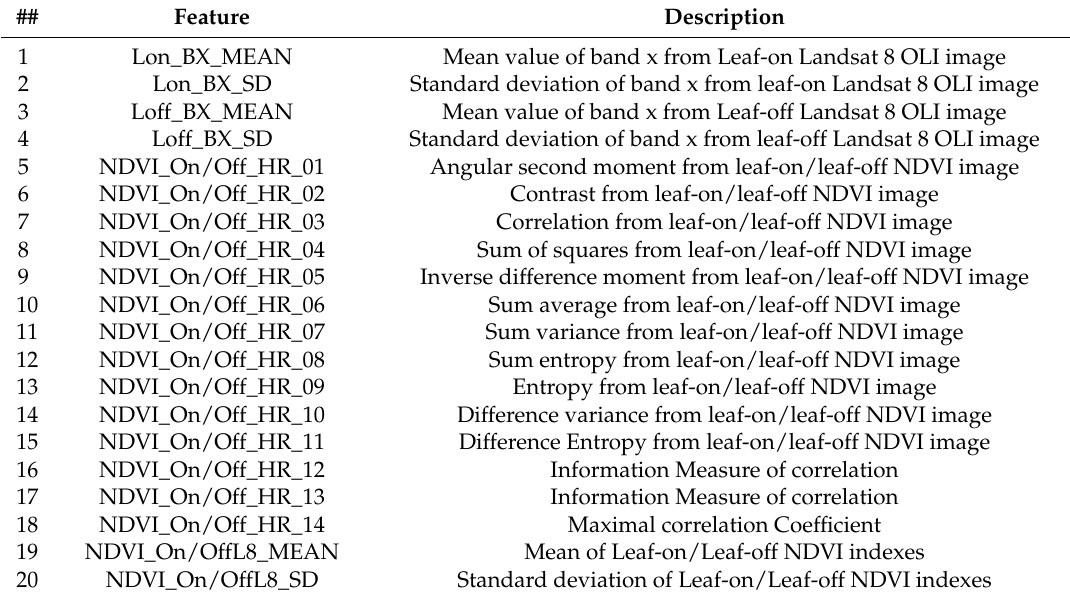
Table A2. Description of the satellite